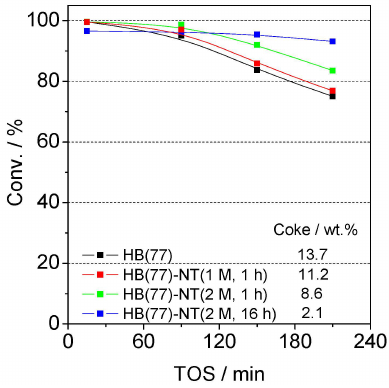
Figure 13. Change in n -hexane conversion with time on stream (TOS) for HB(77) and acid-treated HB catalysts. Reaction conditions: Cat., 0.1 g; P n- hexane = 6 kPa; W / F n- hexane = 64 g h/mol; temperature 923 K.